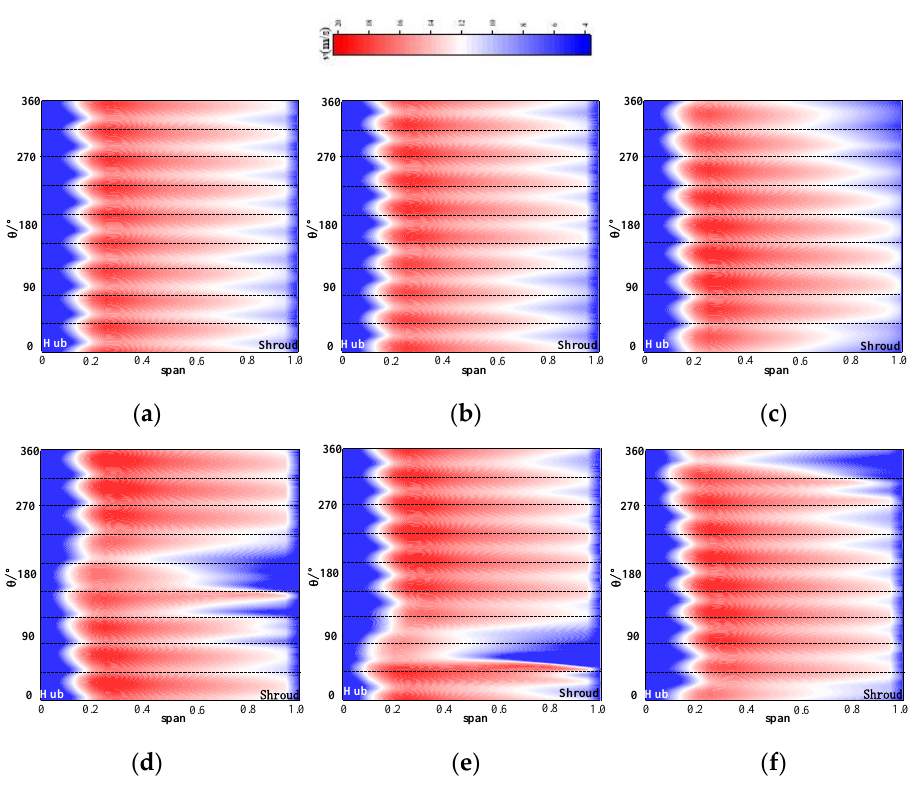
Figure 17. Distribution of transient inflow characteristics at hump point: ( a ) t = b. ( b ) t = c. ( c ) t = d, ( d ) t = e, ( e ) t = f, ( f ) t = g. ( d ) t = e, ( e ) t = f, ( f ) t =